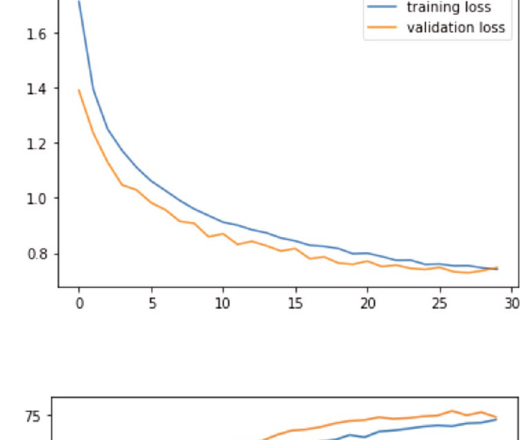
Fig. 9 Training-validation loss